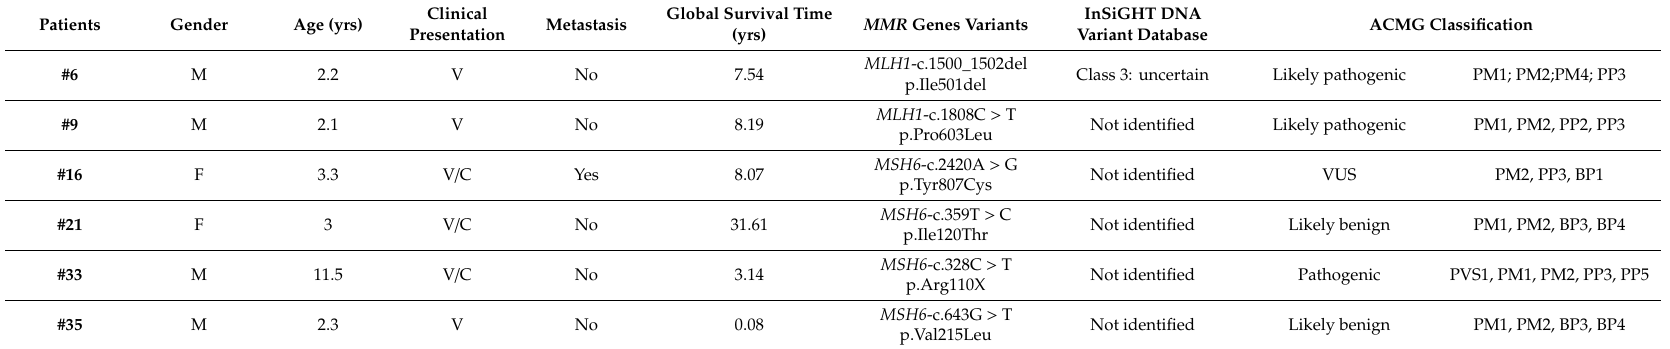
Table 1. Next-generation sequencing (NGS)